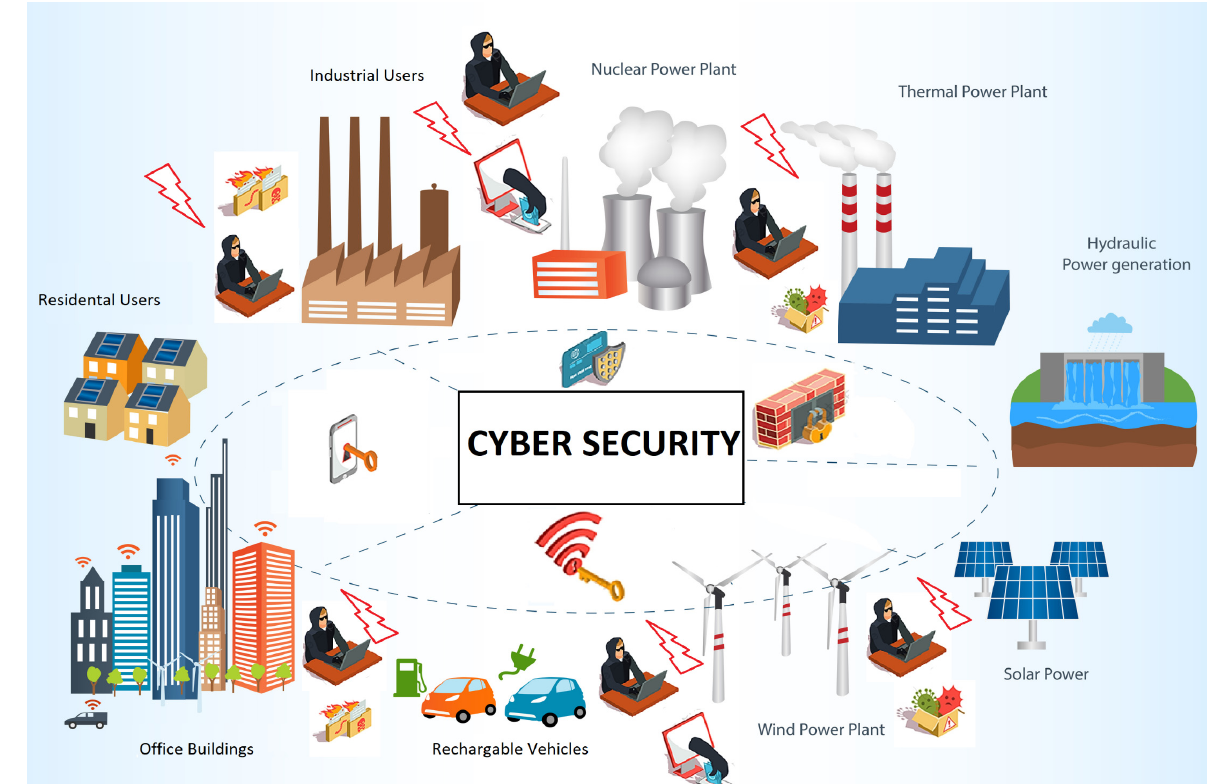
Figure 3. Illustration of cyber security in smart grids.